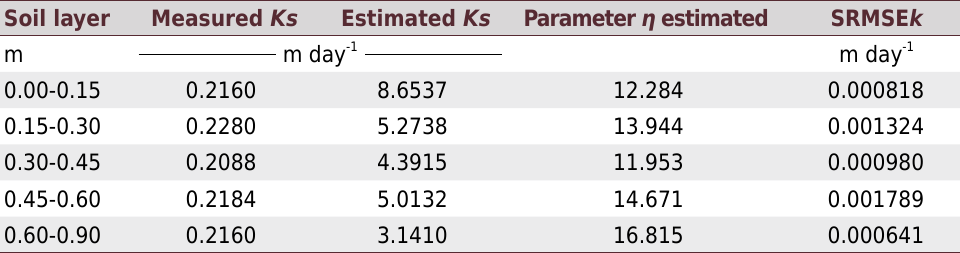
SRMSE k = Square root of the mean squared error between the measured and estimated K